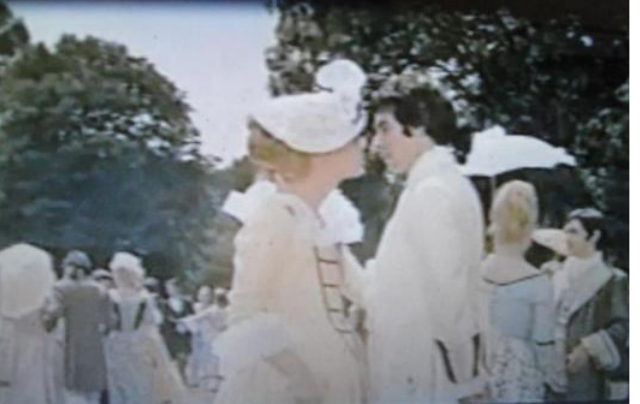
Figure 2: Benjamim (Pierre Clémenti) and his aunt (Michelle